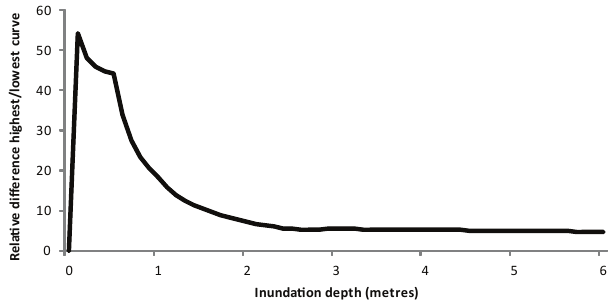
Fig. 9. Relative differences between the highest and lowest relative depth–damage functions for depths between 0 and 6m. For exam- ple, for a depth of 0.5m, the lowest value is 1.5% of maximum dam- age (Rhine Atlas Model) and the highest value 66% (JRC Model), a relative difference of a factor